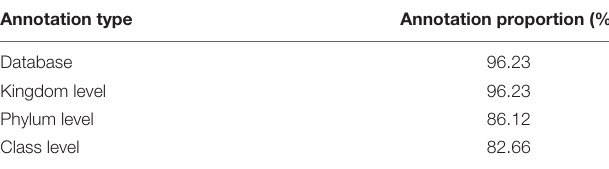
TABLE 1 | Results of OTU annotation under different biological classifications.